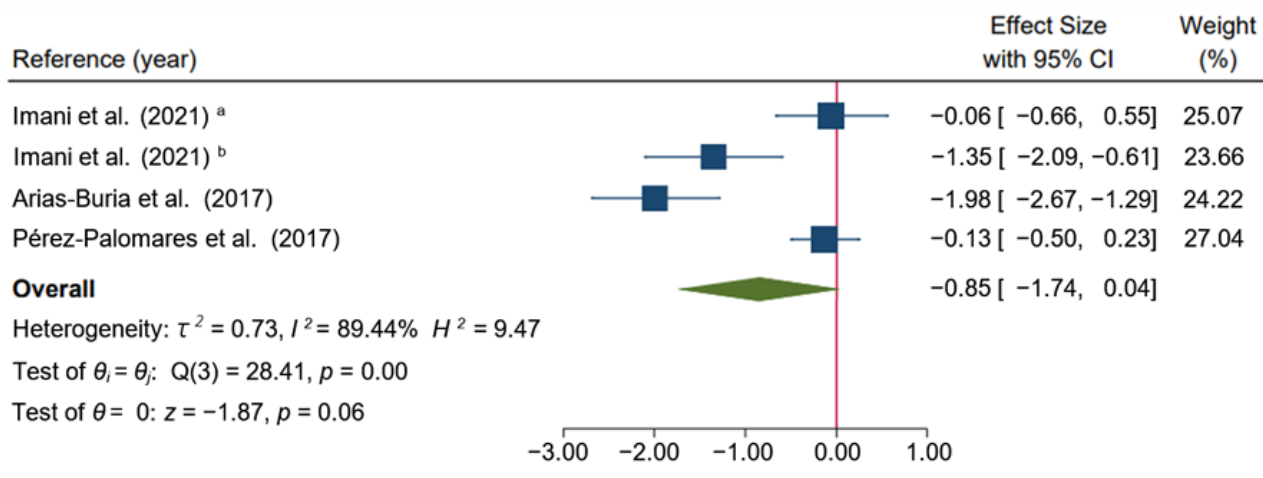
Figure 7. Forest plot of comparison at the mid-term: Dry Needling group alone or combined with exercise therapy versus other types of intervention (exercise, or a combination of exercise, massage, passive mobilization plus hot packs and analgesic electrotherapy), outcome: Disability. a : Hong dry needling technique (fast-in fast-out intervention); b : Deep dry needling (static needling) [32,34,35]. Studies were evenly distributed through the funnel plot for the outcome variable (Figures S1 and S2). However, for the outcome disability, the funnel plot was asymmetric (Figures S3 and S4). Funnel plots can be found in the Supplementary Material.